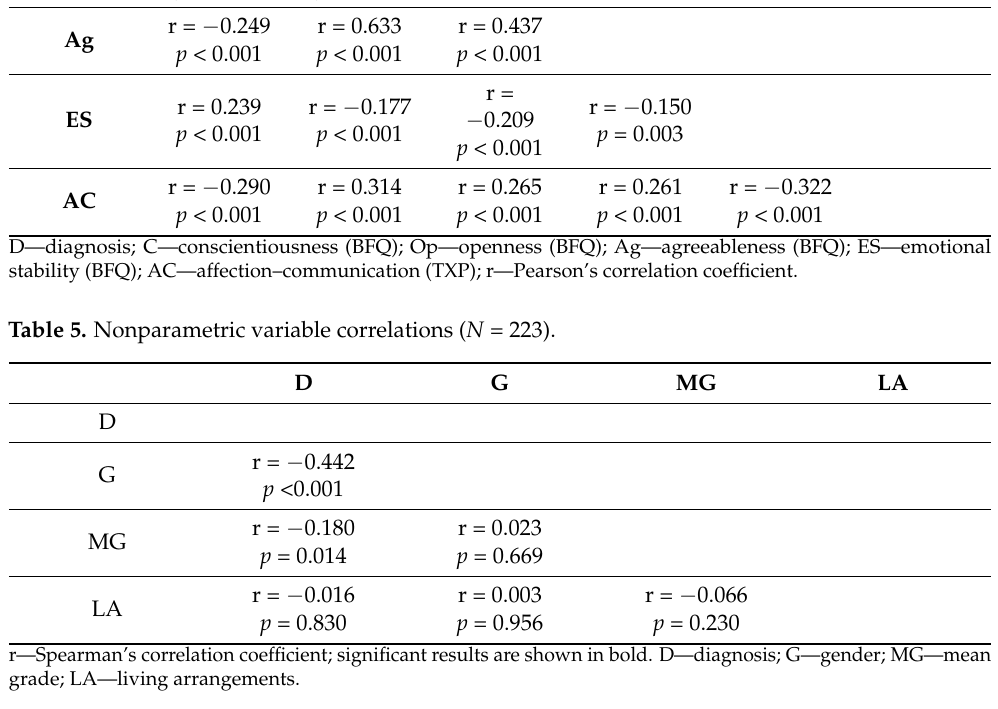
Table 6. Adjusted ( a ) and unadjusted ( b ) multinomial regressions regarding problematic videogame use and dual